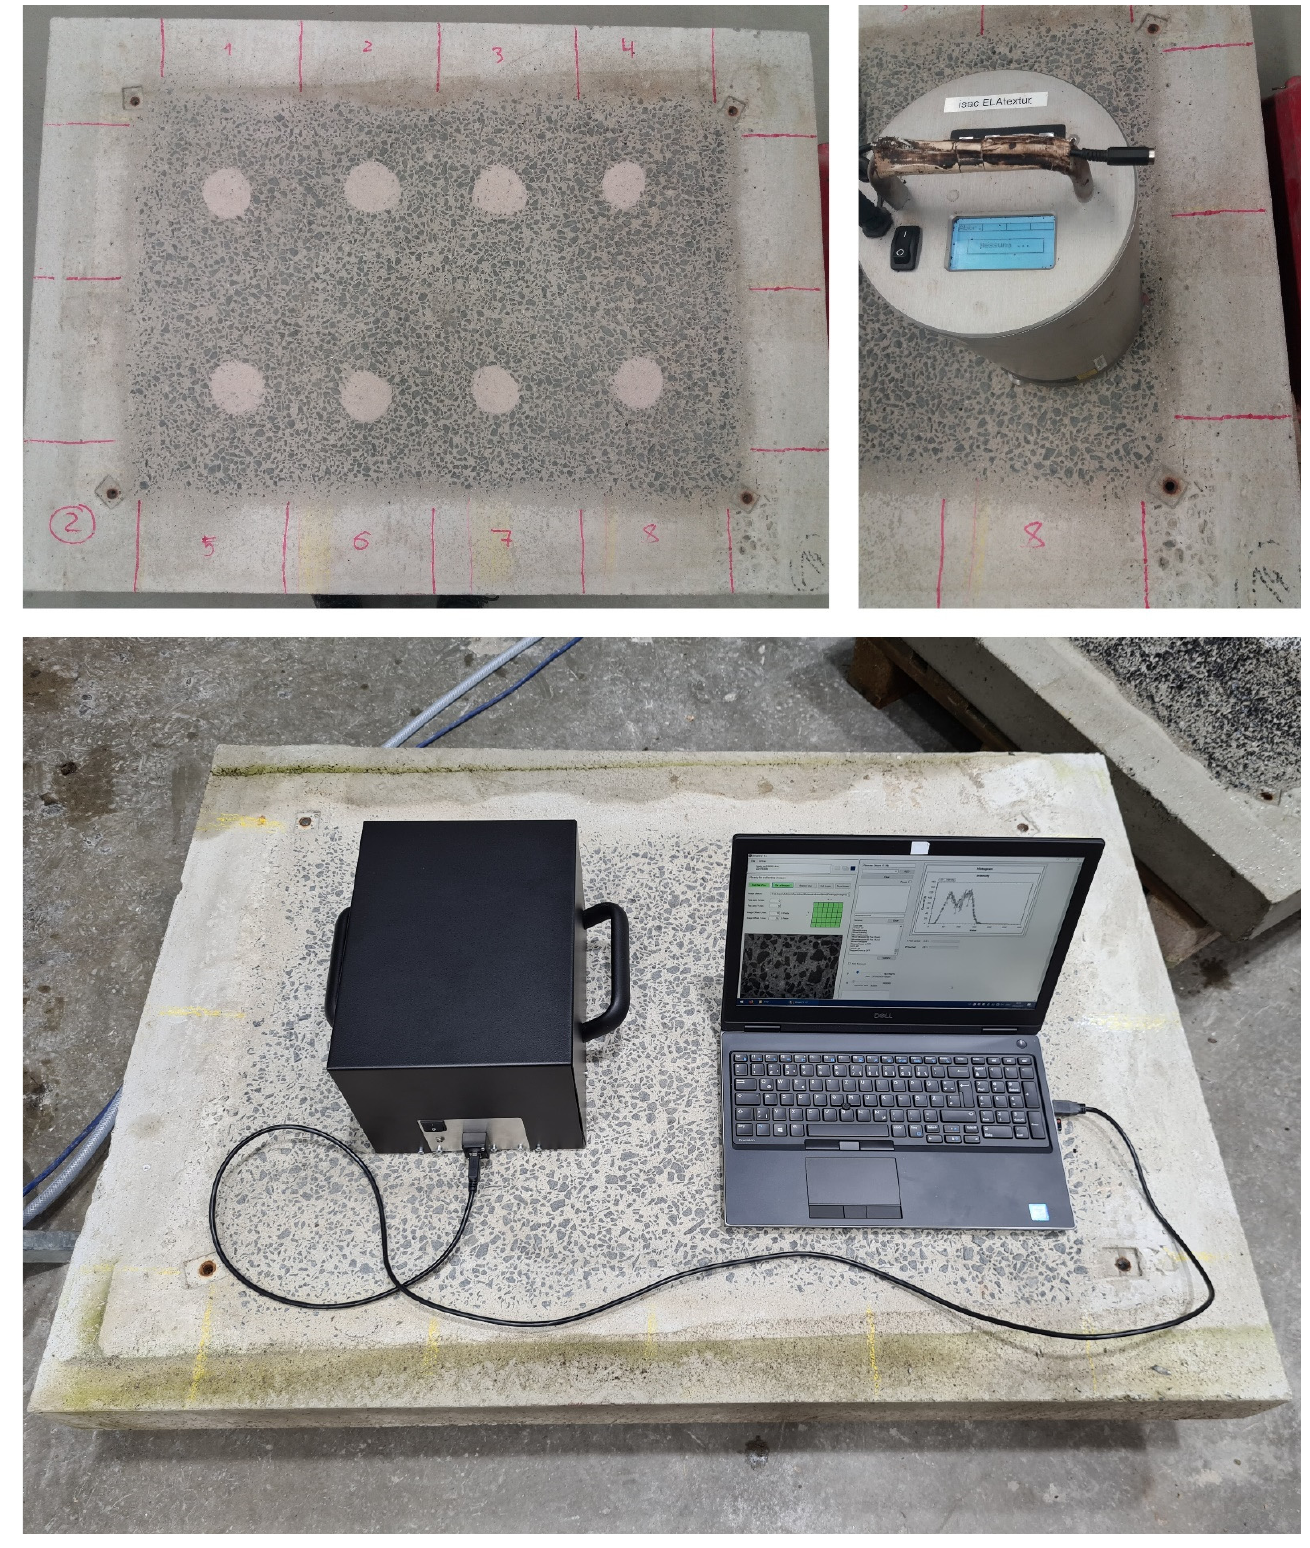
Figure 12. Exemplary measurement setups with all three methods—at top left the sand patch method, at top right the laser triangulation system and at the bottom the camera-based system.